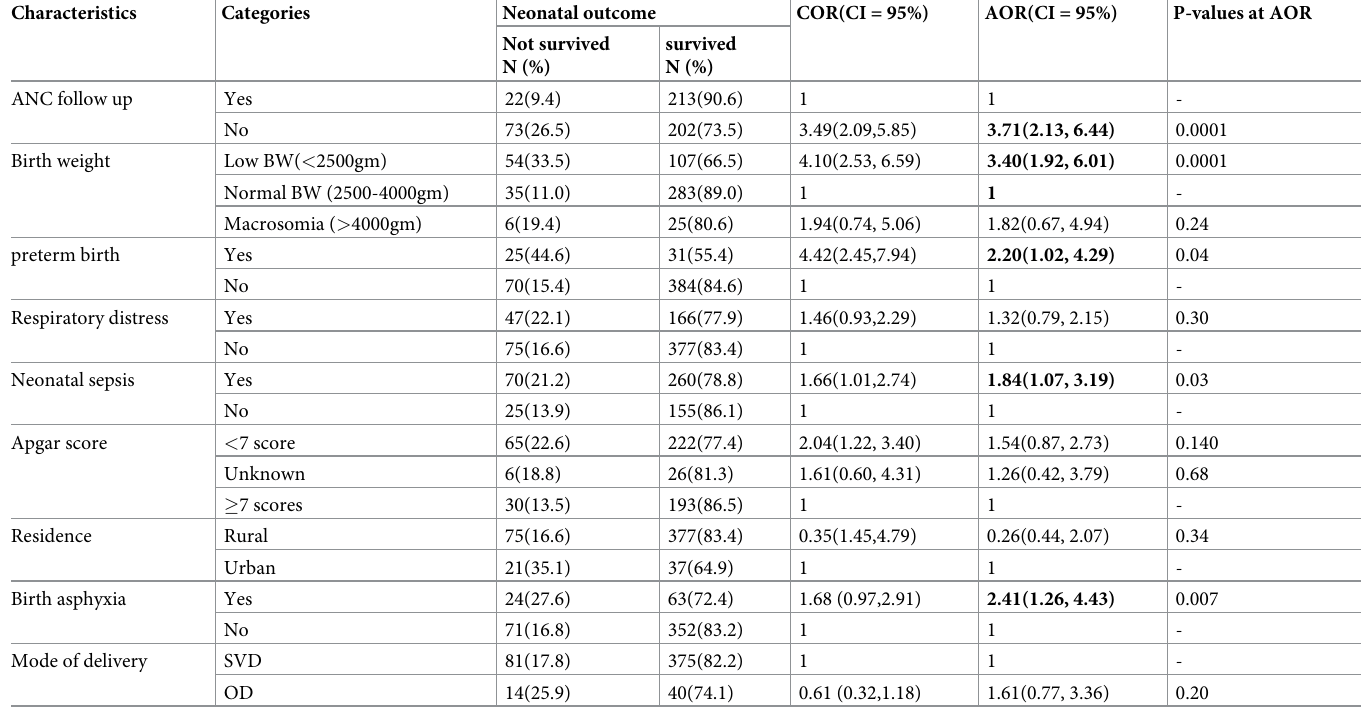
Table 4. Multivariable logistic regression analysis of factors associated with neonatal mortality among neonates admitted to NICU of selected public hospitals in Somali Regional State, Eastern Ethiopia, 2020.